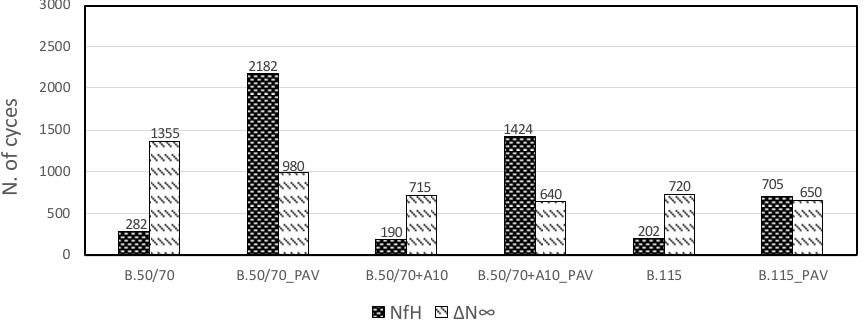
Figure 7. Model parameters for all investigated binders in iso-stiffness condition.